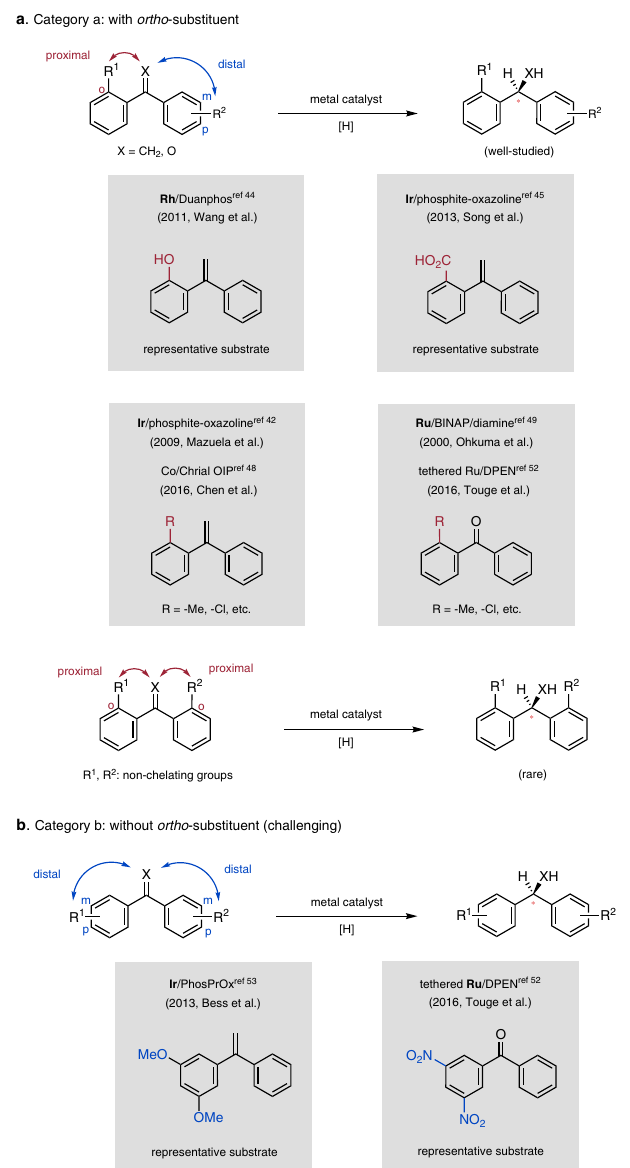
Fig. 1 | Background of metal-catalyzed asymmetric hydrogenation of 1,1-dia- rylethylenes and benzophenones. a Metal-catalyzed asymmetric hydrogenation of 1,1-diarylethylenes and benzophenones with ortho -substituent. b Metal- catalyzed asymmetric hydrogenation of 1,1-diarylethylenes and benzophenones without ortho -substituent.